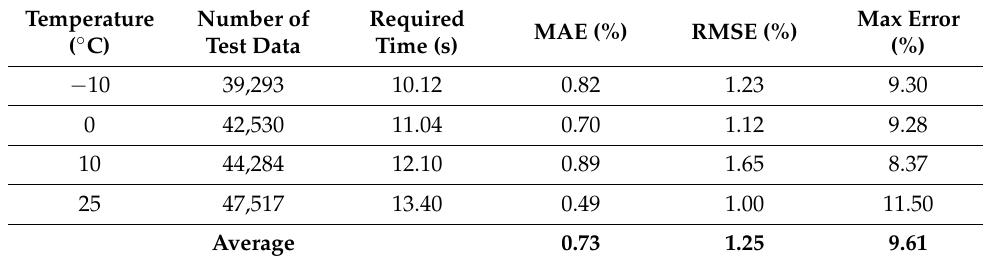
Table 3. Test results of the CNN-LSTM